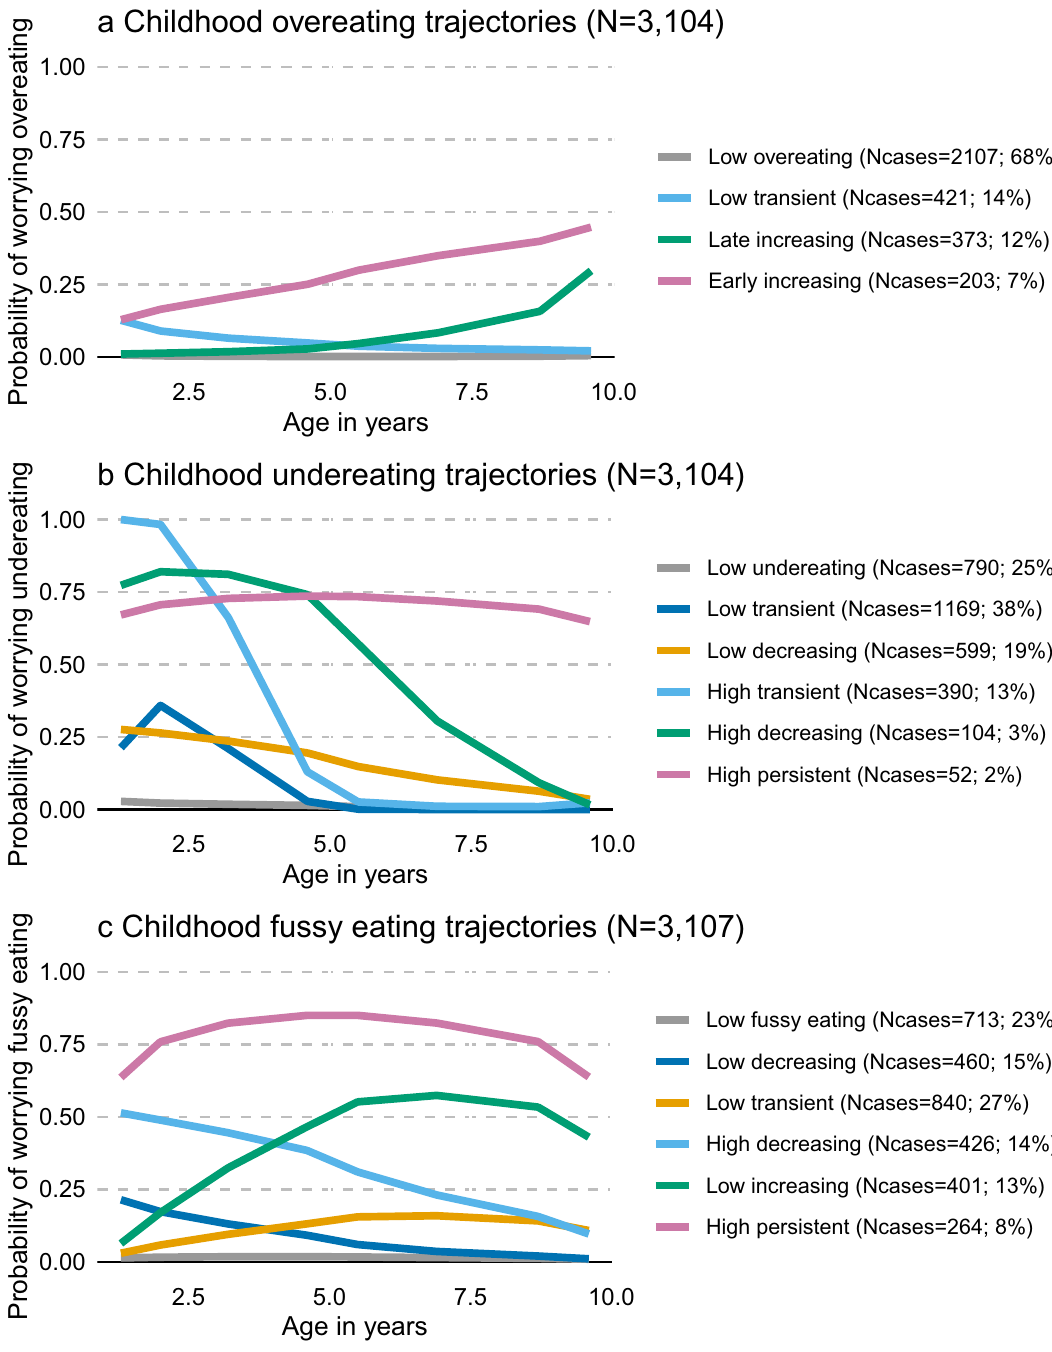
Figure 1. Trajectories of parent-reported child eating behaviours: overeating, undereating, and fussy eating. Trajectories are created using latent class growth analysis. Participants (n = 3107) with at least one measure of eating behaviour and metabolic data at 16 years in the Avon Longitudinal Study of Parents and Children are